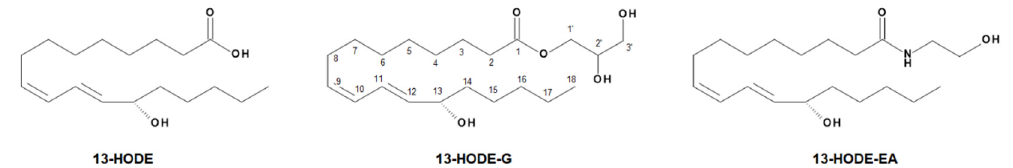
Figure 1. Chemical structures of 13-HODE, 13-HODE-G, and 13-HODE-EA.